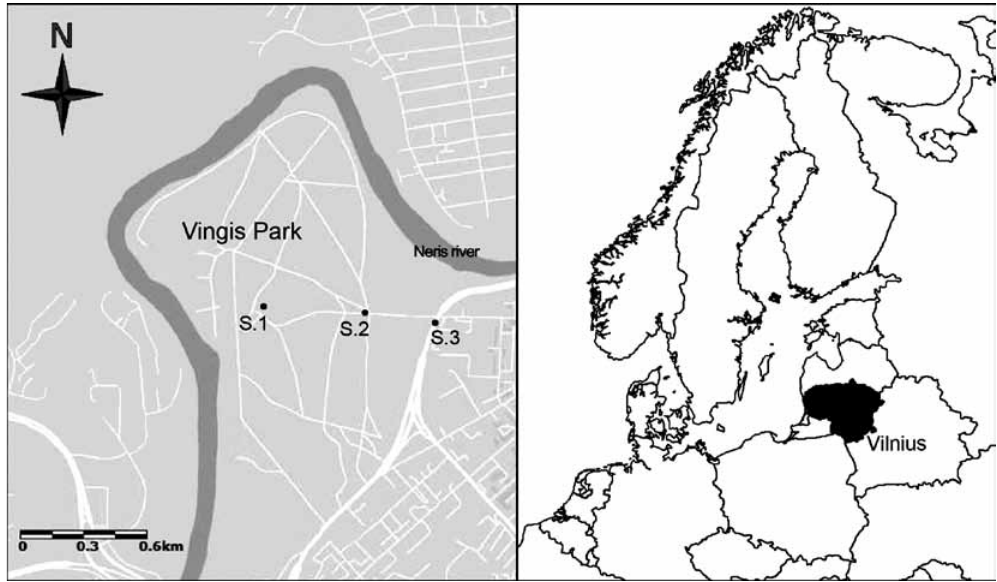
Fig. 1. Location of Lithuania in the Baltic Sea region. Location of the sampling sites in the area of Vingio Park, in Vilnius, Lithuania. The dots indicate the sampling points along M.K. čiurlionio St.: S.1 is the roof site; S.2 is the pathway site; S.3 is the road